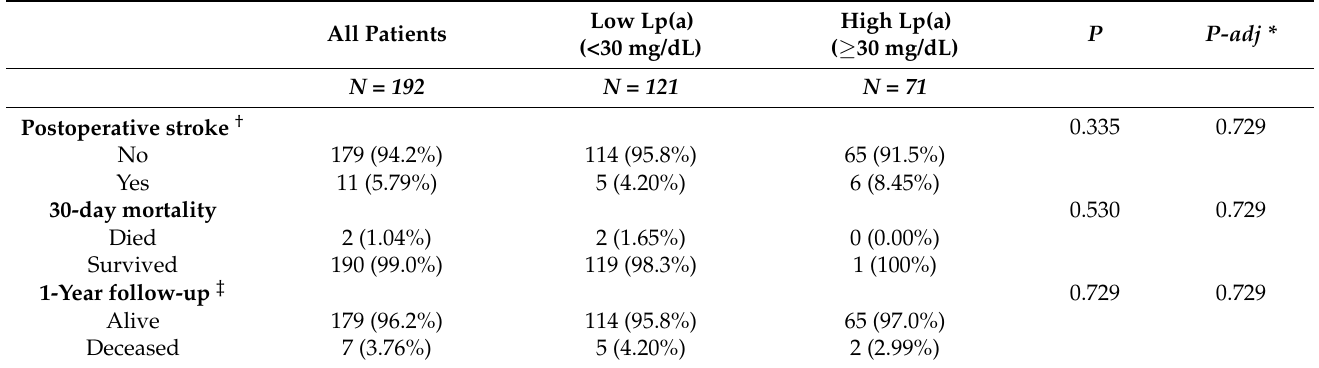
Table 2. Primary outcomes.